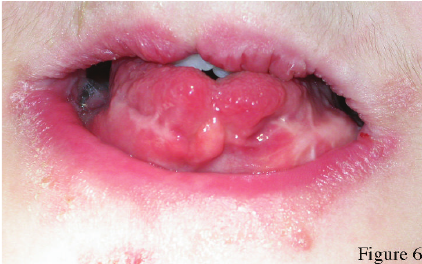
Figure 6: Tongue of the patient. Note the surgery scars secondary to tumor-like lesions.